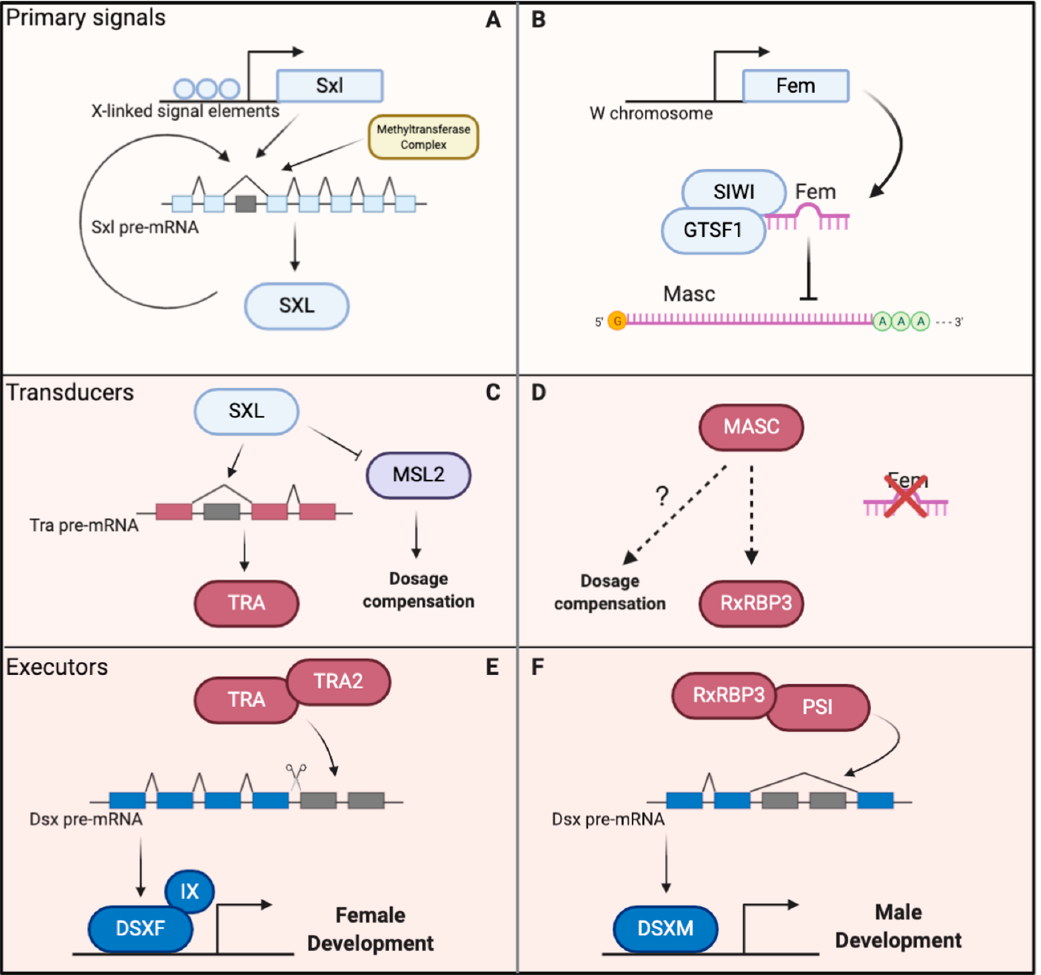
Figure 2. Comparison of the sex determination cascade between Drosophila melanogaster ( A , C and E ) and Bombyx mori ( B , D and F ). In female D. melanogaster , the dosage of several X-linked signal element proteins regulates the transcription initialization of Sex-lethal ( Sxl ). An autoregulatory feedback loop ensures continuous expression. Methyltransferase com- plex components also regulate the precise splicing of Sxl ( A ) [92–95]. The Sxl protein (SXL) directly binds to transformer ( tra ) pre-mRNA and regulates its alternative splicing. Male-specific-lethal 2 (Msl2) is inhibited at the mRNA level ( C ). Func- tional transformer protein (TRA) with transformer-2 protein (TRA2) together regulate doublesex ( dsx ) female-specific alter- native splicing ( E ) [5]. The female-specific DSX (DSXF) interacts with Intersex protein (IX) to promote female development [86]. In female B. mori , the Fem inizer piRNA ( Fem ) derived from the female W chromosome is postulated to interact with the protein Silkworm-PIWI (SIWI) and gametocyte-specific factor 1 (GTSF1) to form the piRNA-induced silencing complexes that silences Masculinizer ( Masc ) at the mRNA level ( B ) [24,25,28]. In male B. mori , the Masc protein (MASC) increases the expression of Bombyx mori dsx RNA-binding protein 3 (RxRBP3) ( D ). RxRBP3, together with the protein of P-element somatic inhibitor (PSI), regulates the male-specific alternative splicing of dsx ( F ) [26,72,87,96]. The male-specific DSX (DSXM) pro- motes male development [37,38]. 6. Conclusions and Perspectives Genetic, molecular and biochemical studies demonstrate that the sex-determination system in the silkworm, a model lepidopteran insect, is very different from that in Diptera [11]. Although several factors have been characterized in the silkworm, how they are func- tionally correlated with each other is still unclear [24–28,33]. Moreover, no factors that specifically control sex transformation have been discovered, making the sex determina- tion cascade in the silkworm elusive. If Fem as the primary signal is dominant in the sex determination cascade, overexpressing Fem in males may cause a male-to-female change.